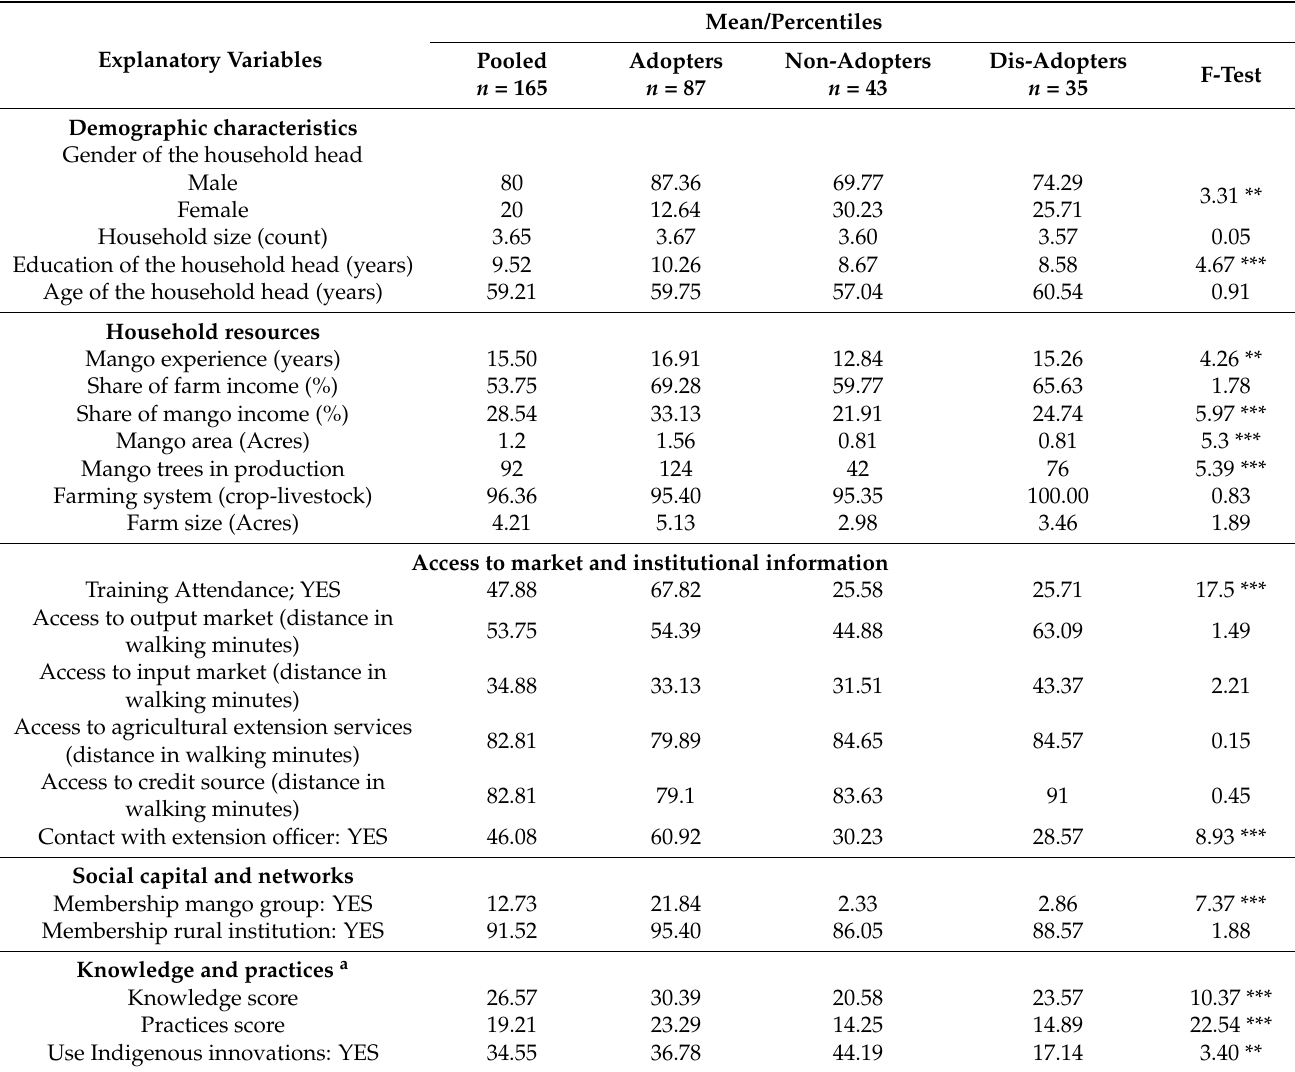
Table 2. Comparison of farm and farmer characteristics of sample households across different fruit fly IPM adoption groups in Embu county,